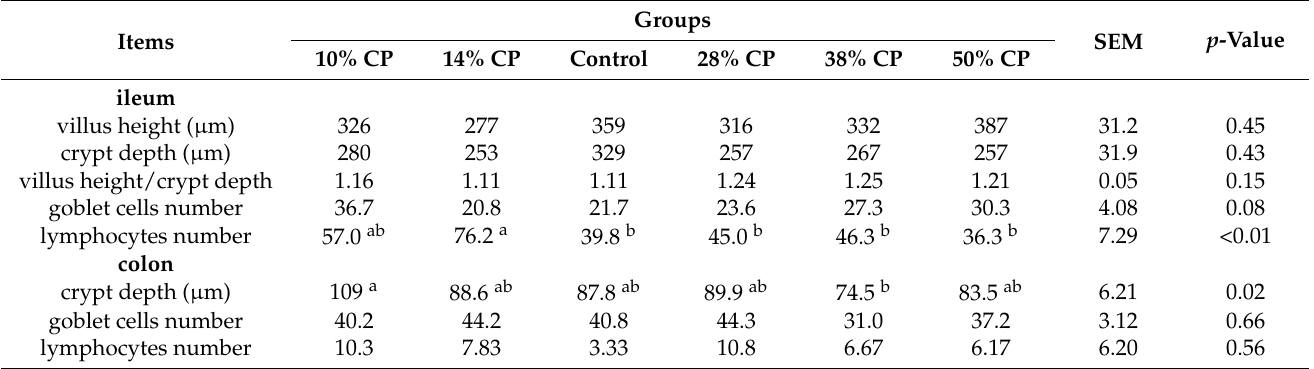
Table 3. Effects of dietary protein contents on the intestinal mucosa morphology and goblet cell and lymphocyte population of SD rats.